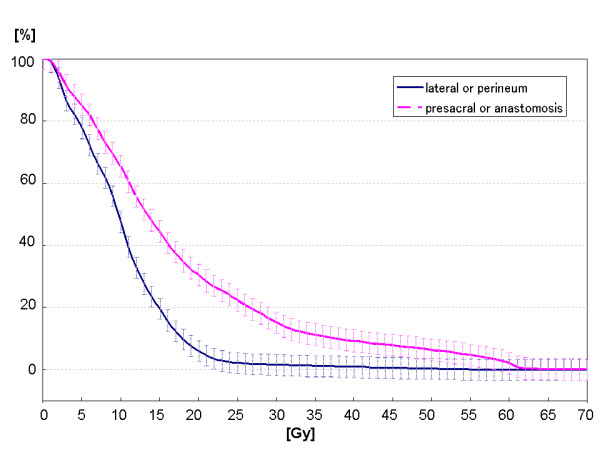
Mean DVH of small bowel PRV of summed plan 3 in patients with lateral pelvic lymph node metastasis or perineum recurrence and that in patients with presacral or anastomostic recurrence. In patients with lateral pelvic lymph node metastasis or perineum recurrence, the mean DVH of small bowel PRV of summed plan 3 was significantly lower than that in patients with presacral or anastomostic recurrence.